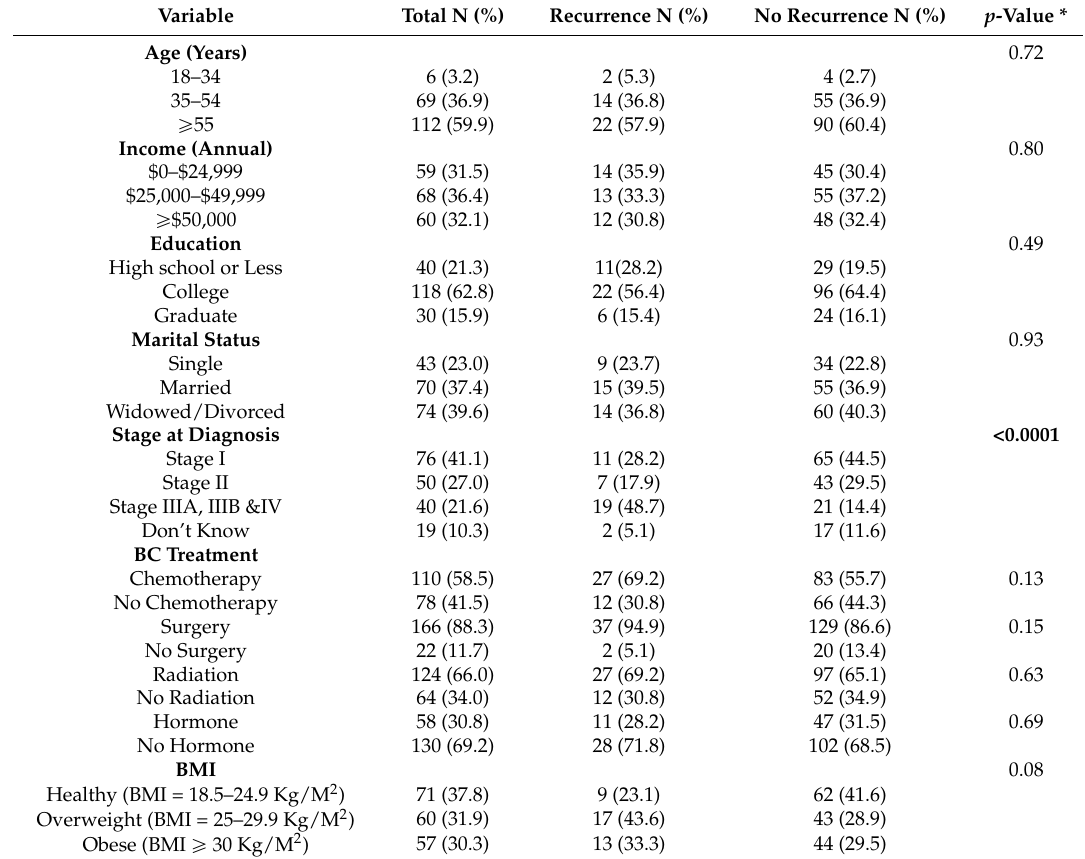
Table 1. Characteristics of African American breast cancer survivors by breast cancer recurrence status. Variable Total N